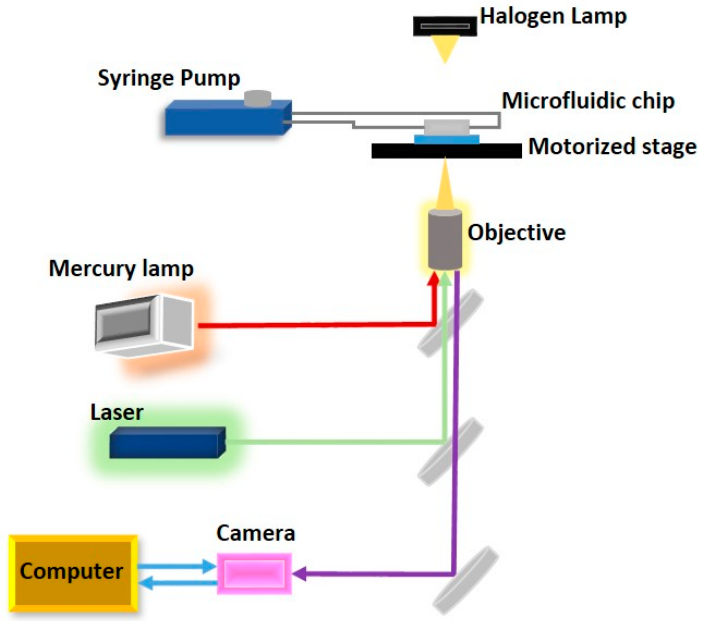
Figure 12. Schematic representation of cell manipulation using computer-controlled motorized stage. Redrawn from [93].